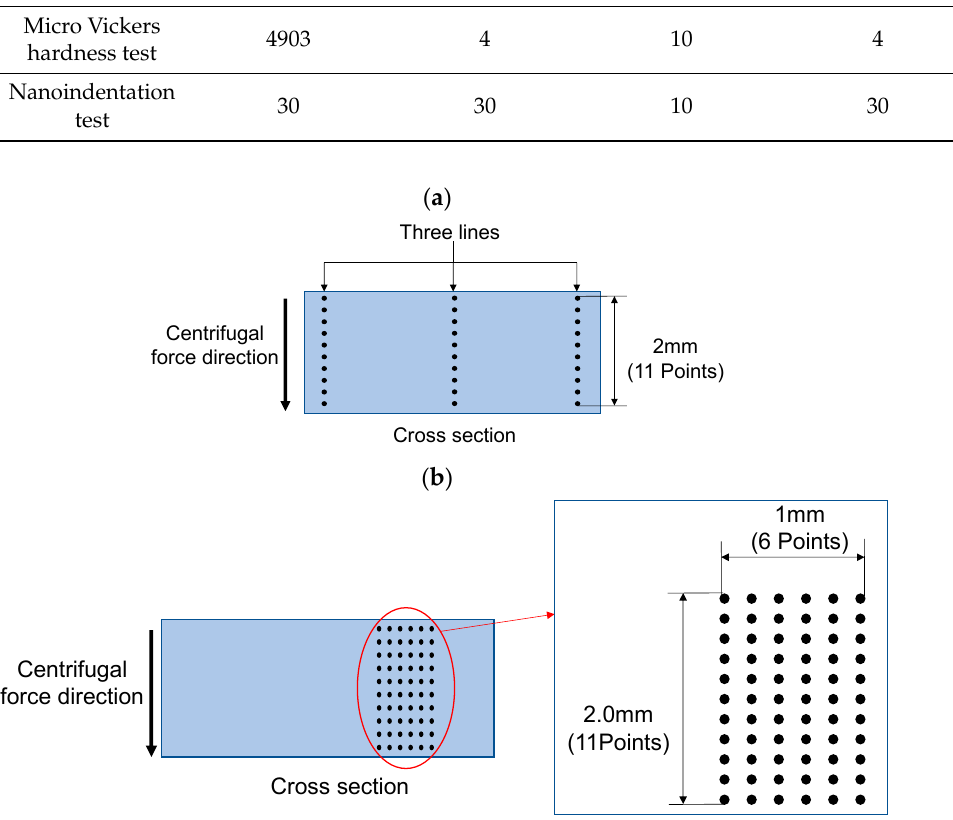
Figure 5. Hardness testing points for ( a ) Micro Vickers hardness test, and ( b ) Nanoindentation test.